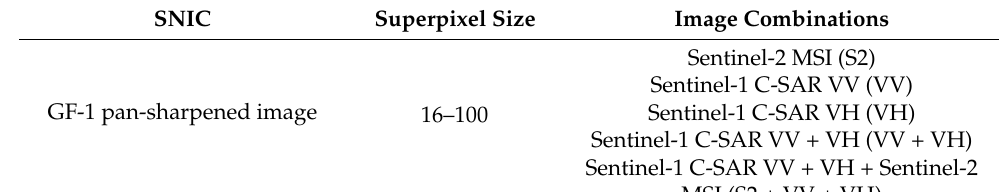
Table 3. Classification schemes.